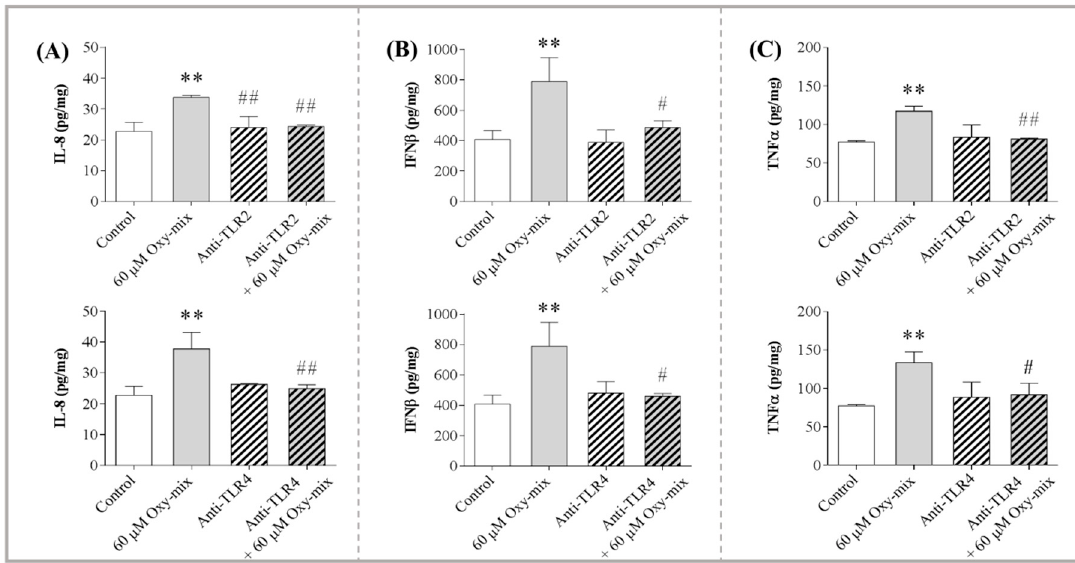
Figure 2. TLR2 and TLR4 are involved in Oxy-mix-dependent cytokine production. Di ff erentiated CaCo-2 cells were pre-treated (1 h) with 0.2 µ g / mL anti-TLR2 or anti-TLR4 antibodies, and then treated with 60 µ M Oxy-mix for 24 h. IL-6 (panel A ), IFN β (panel B ) and TNF α (panel C ) levels were quantified by ELISA test in cell culture medium. Ab pre-treatment was able to fully prevent the Oxy-mix-dependent cytokine protein level increase in the cell medium. Values are shown as pg interleukin released / mg protein present in 1 mL cell incubation medium and are referred as means ±